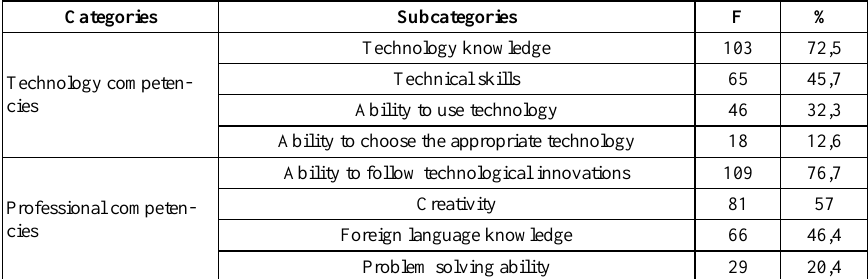
Table 3. Opinions of students on the use of technology in the